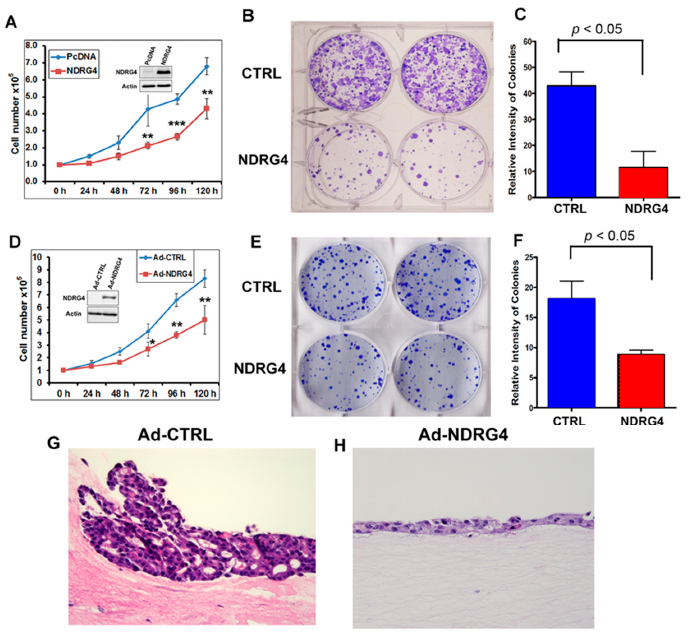
Figure 5. Exogenous expression of NDRG4 suppressed EAC cell growth. ( A – C ) FLO1 cells were forced expression of NDRG4 using PcDNA plasmid model followed by performing cell growth